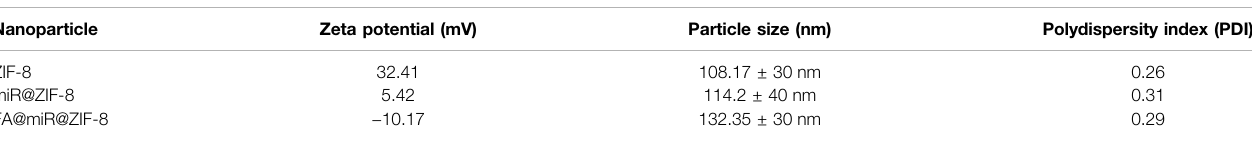
TABLE 1 | Zeta potential, particle size, and polydispersity index of